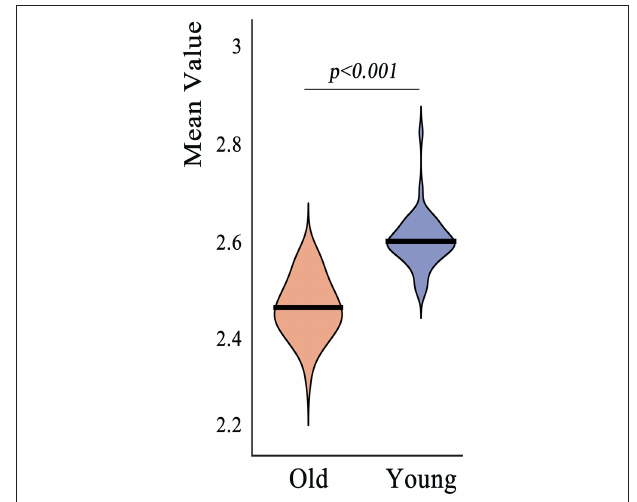
FIGURE 6 | Region of interest analysis revealed significant decrease in mean cortical thickness across whole cerebral cortex in old adults compared to young